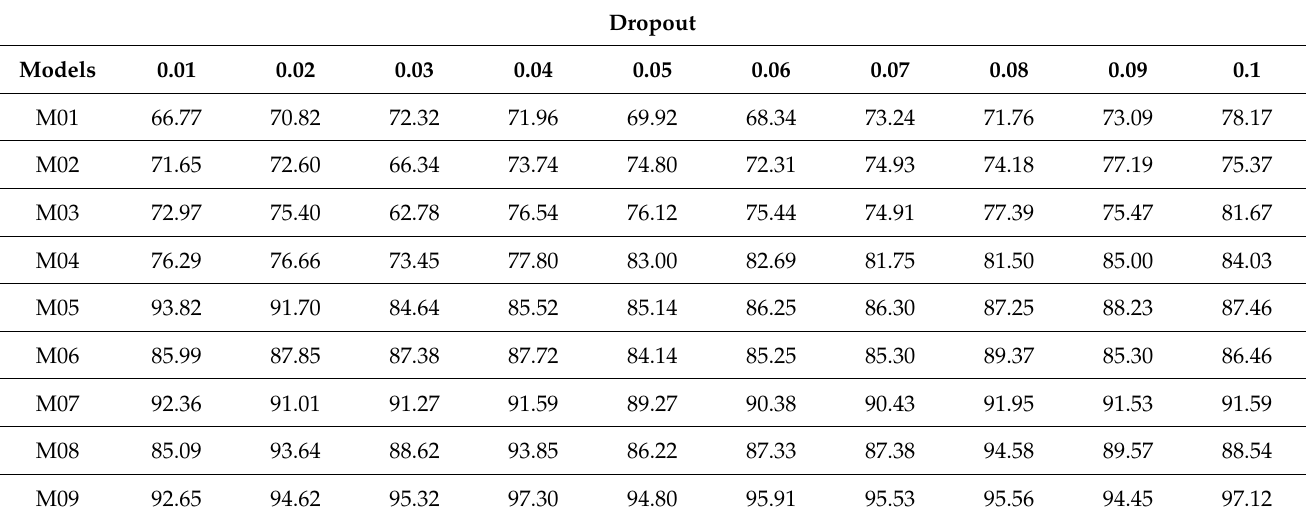
Table 9. Average classification accuracy (%) results for an embedding size of 300.